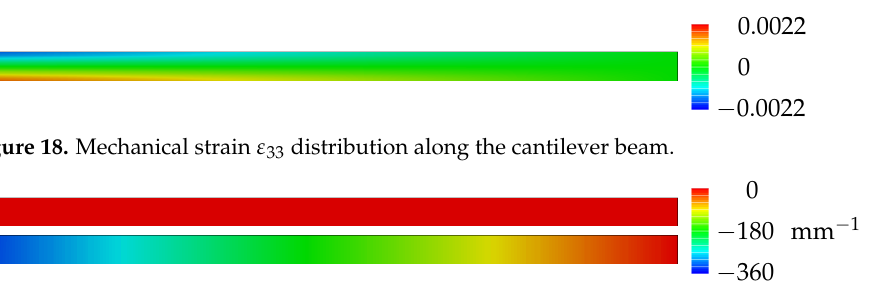
Figure 19. Comparison of mechanical strain gradient η 333 distribution for the linear (top) and quadratic (bottom) element along the cantilever